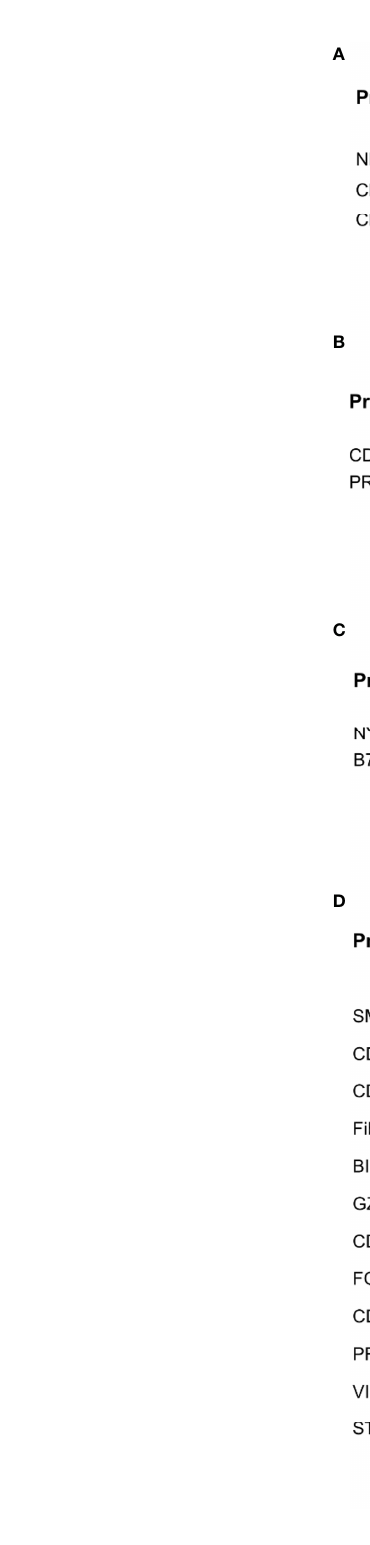
FIGURE 4 | Identi fi cation of proteins with overall survival associations. (A, B) Forest plot indicating hazard ratio with 95% con fi dence interval for proteins from primary specimens. (C, D) Forest plot indicating hazard ratio with 95% con fi dence interval for proteins from nodal metastases. HR >1 demonstrates association with poorer